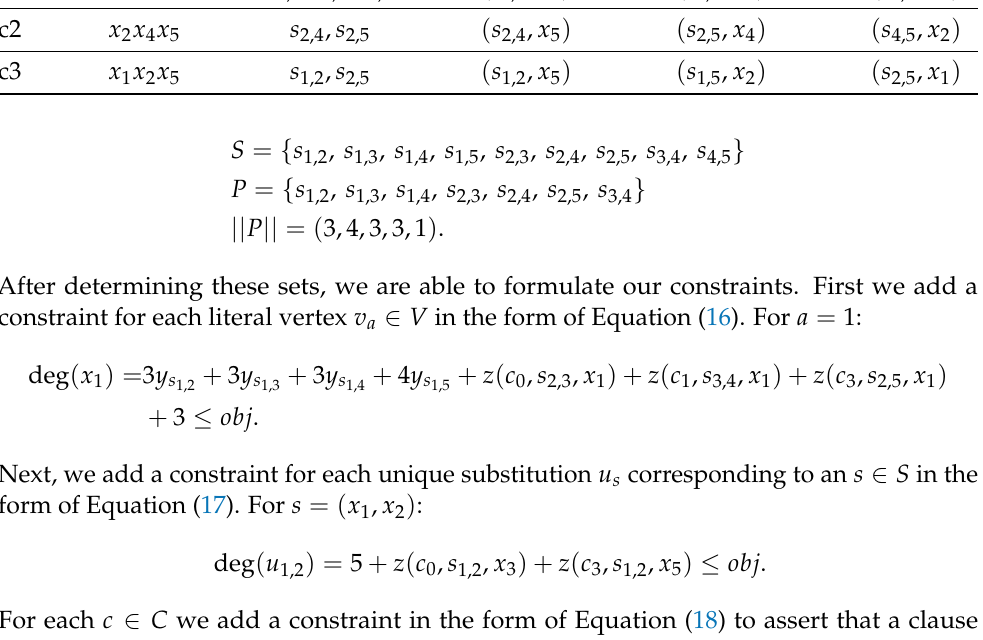
Table 2. This table shows the result of the reformulation of each 3-SAT clause including the three variable monomials to be covered c , the two variable monomial pairs from the expansion of each P , and each of the three potential coverings of c , ( s i , j , x k ) . clause s ∈ c ( x i x j x k ) s i , j ∈ P Covering 1 Covering 2 Covering 3 c0 x 1 x 2 x 3 s 1,3 , s 2,3 ( s 1,2 , x 3 ) ( s 1,3 , x 2 ) ( s 2,3 , x 1 ) c1 ( s 3,4 , x 1 )